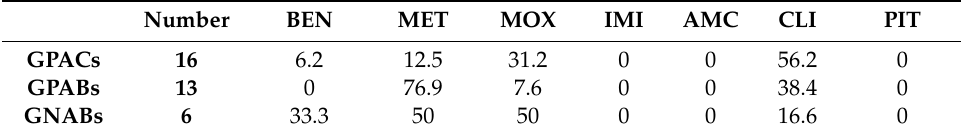
Table 3. Resistance rate (%) of anaerobic bacteria against selected antimicrobial agents obtained from breast abscesses. Number BEN MET MOX IMI AMC CLI PIT